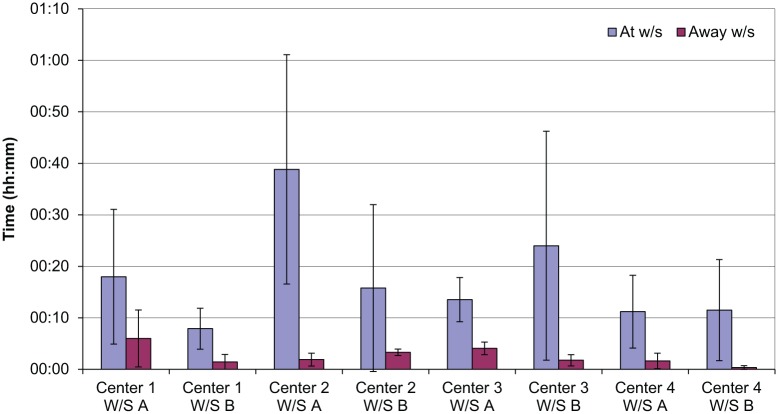
Quiet time results.